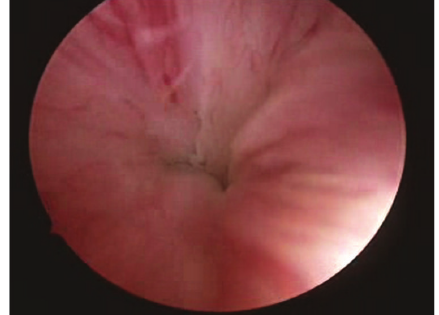
Figure 3: Coapted bladder